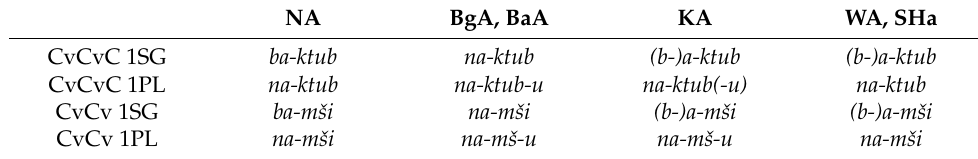
Table 3. 1SG/1PL marking in prefixed conjugation.